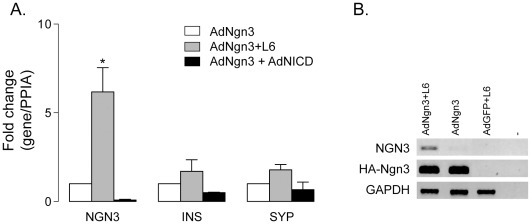
Modulation of Delta-Notch signaling affects Ngn3 induced endocrine differentiation in adult human duct cells.(A) Real time PCR quantification of endogenous Ngn3, Ins and Syp in AdGFP-Ngn3 transduced duct samples (white bars) versus gamma-secretase inhibitor L6-treated samples (gray bars), shows increased expression levels of endogenous NGN3 (*P<0.05) and the endocrine marker genes (NS, n = 3). Expression of Ngn3, Ins and Syp is reduced when AdGFP-Ngn3 cells are additionally transduced with the Notch1 intracellular domain (NICD) (black bars). Data represent mean ± SEM real-time PCR measurements of target/Ppia mRNA levels compared to AdGFP-Ngn3 transduced duct cells. (B) Conventional PCR showing an increased activation of endogenous HsNgn3 in AdGFP-Ngn3 adult human duct cells treated with L6, but no effect in control transduced duct cells. Controls of exogenous expression (HA-Ngn3 and GFP) as well as expression levels of housekeeping gene GAPDH are shown.